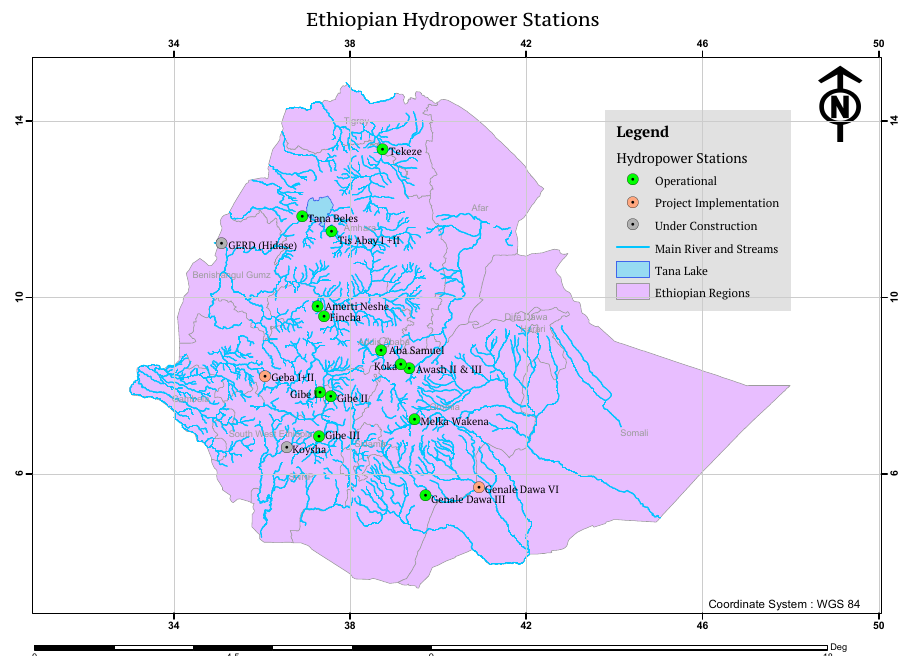
Figure 1. Map of Ethiopian Hydropower